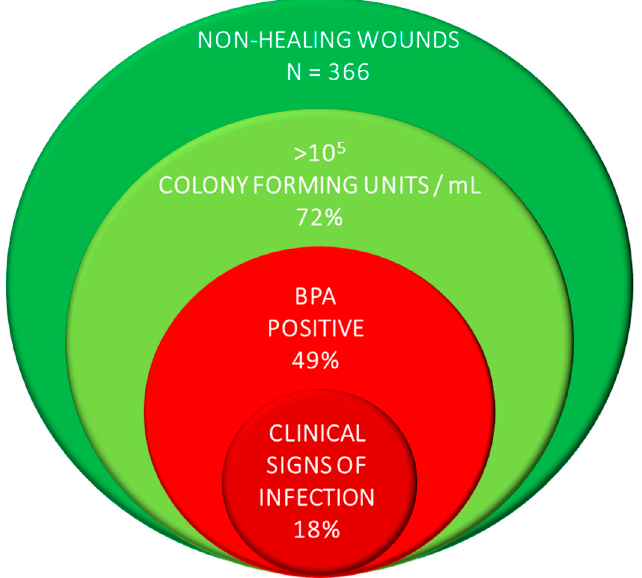
Figure 3. A large multicenter clinical trial demonstrates that wounds with pathogenic bacteria have no signs or symptoms of